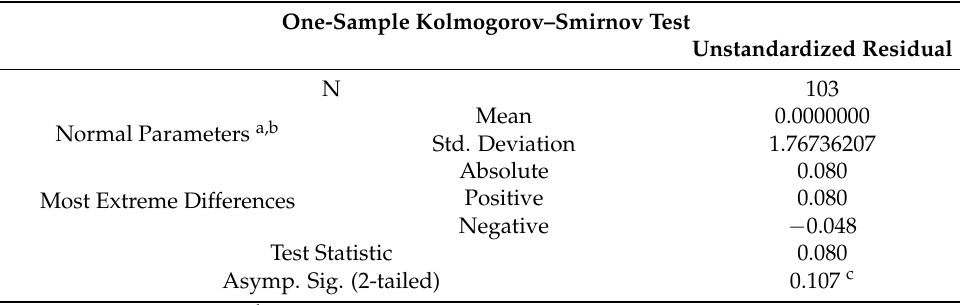
Table A1. One-Sample Kolmogorov–Smirnov Test results.